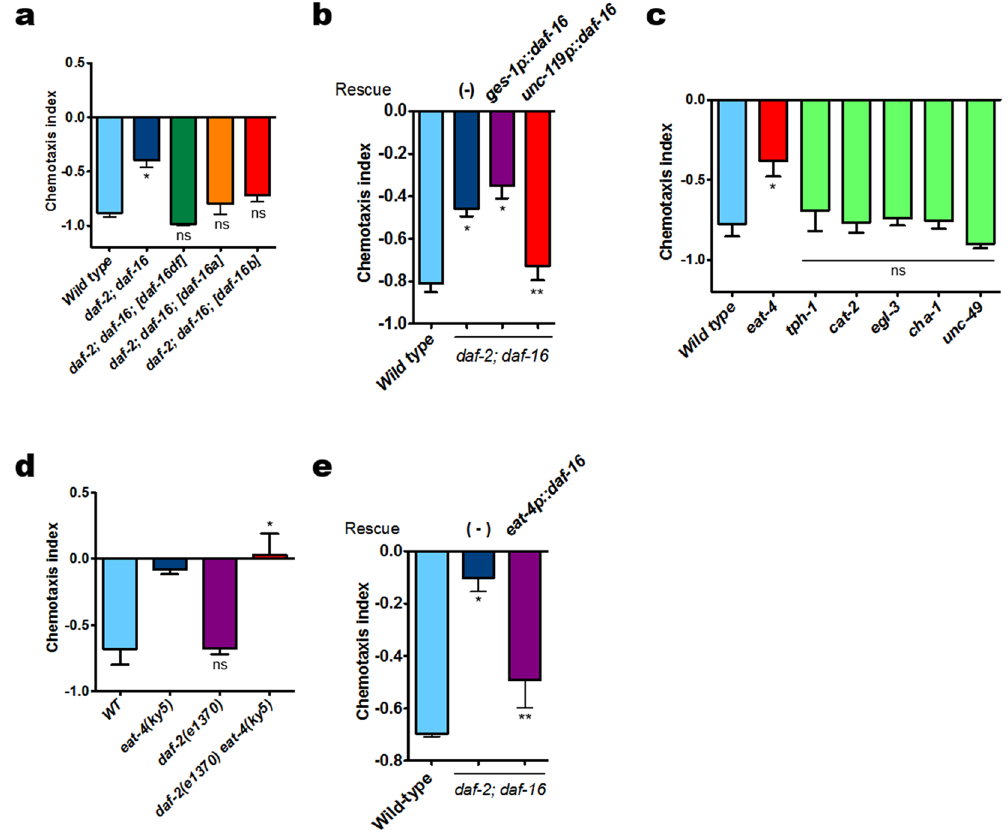
Figure 1. Glutamate signaling mediates pheromone sensory signals to produce repulsion response through the insulin/IGF-1 signaling. ( a ) Rescuing the daf-2 ( e1370 ) ;daf-16/FoxO ( mgDf50 ) phenotype with different daf-16/FoxO isoforms (wild type, n = 145; daf-2;daf-16/FoxO , n = 196; daf-2;daf-16/FoxO ; DAF-16/FoxOa , n = 146; daf-2;daf-16/FoxO ; DAF-16/FoxOdf , n = 218; daf-2;daf-16;DAF-16/FoxOb , n = 133). ( b ) Tissue-specific rescue of daf-2;daf-16/FoxO phenotype (wild type, n = 149; daf-2;daf-16/FoxO, n = 225; daf-2;daf-16/FoxO ; ges- 1P::DAF-16/FoxO , n = 150; daf-2;daf-16/FoxO;unc-119P::DAF-16/FoxO , n = 142). DAF-16/FoxO cDNA was expressed under control of intestine- ( ges-1P ) or pan-neuronal-specific ( unc-119P ) promoters. ( c ) eat-4 ( ky5 ) mutants deficient in glutamate transporter showed defective repulsion responses. ( d ) Genetic epistasis between daf-2 and eat-4 mutants (wild type, n = 58; eat-4 , n = 47; daf-2 , n = 68 ; daf-2 eat-4 , n = 62). (e) DAF-16/FoxO in glutamatergic neurons rescued daf-2;daf-16/FoxO repulsion responses (wild type, n = 79; daf-2;daf-16/FoxO , n = 94; daf-2;daf-16/FoxO ; eat-4P::daf-16/FoxO , n = 80). DAF-16/FoxO cDNA was expressed under control of the eat-4 promoter. * P < 0.05 , ns: not significant compared to wild type. ** P < 0.05 compared to daf-2;daf-16/ FoxO . Significance was determined using two-tailed, unpaired t -tests. In these experiments, daumone 1 (1 μ M) was singly used in